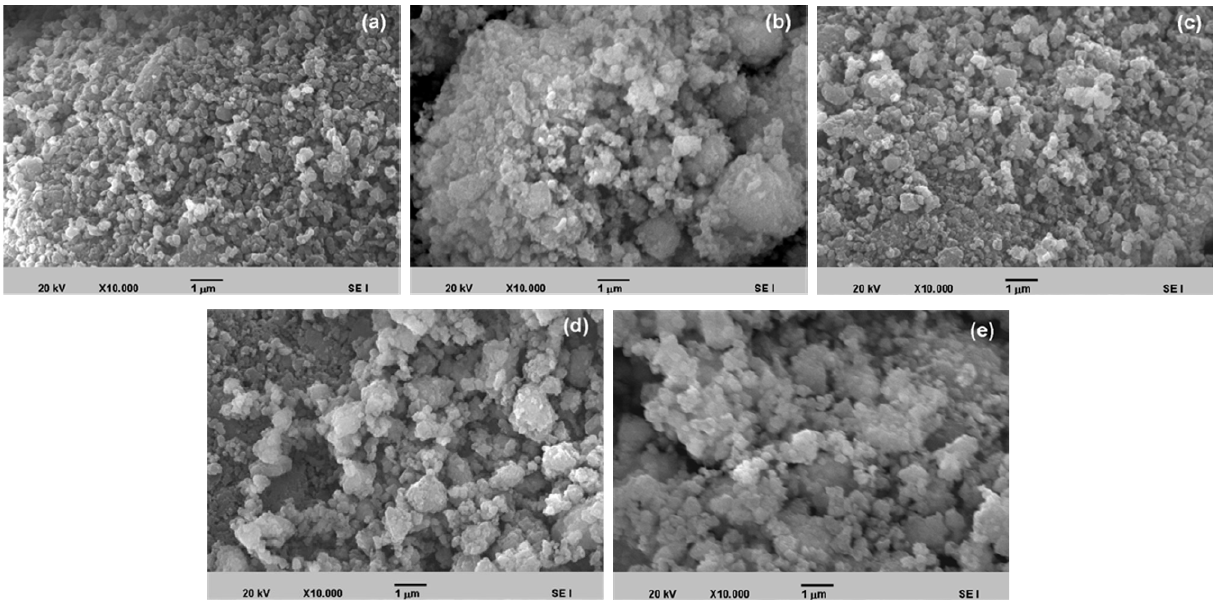
Fig. 6 SEM micrographs and particle size analysis of the mechanically activated powders for (a) 5, (b) 15, (c) 30, (d) 60, and (e) 120